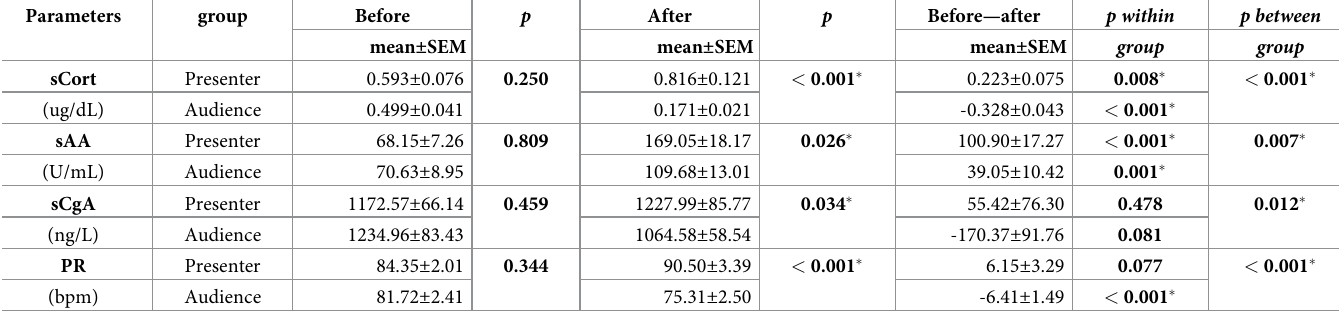
Table 1. Mean salivary cortisol, amylase, chromogranin A levels, and pulse rates before class and after oral presentation (in presenters) or during class (in audience).